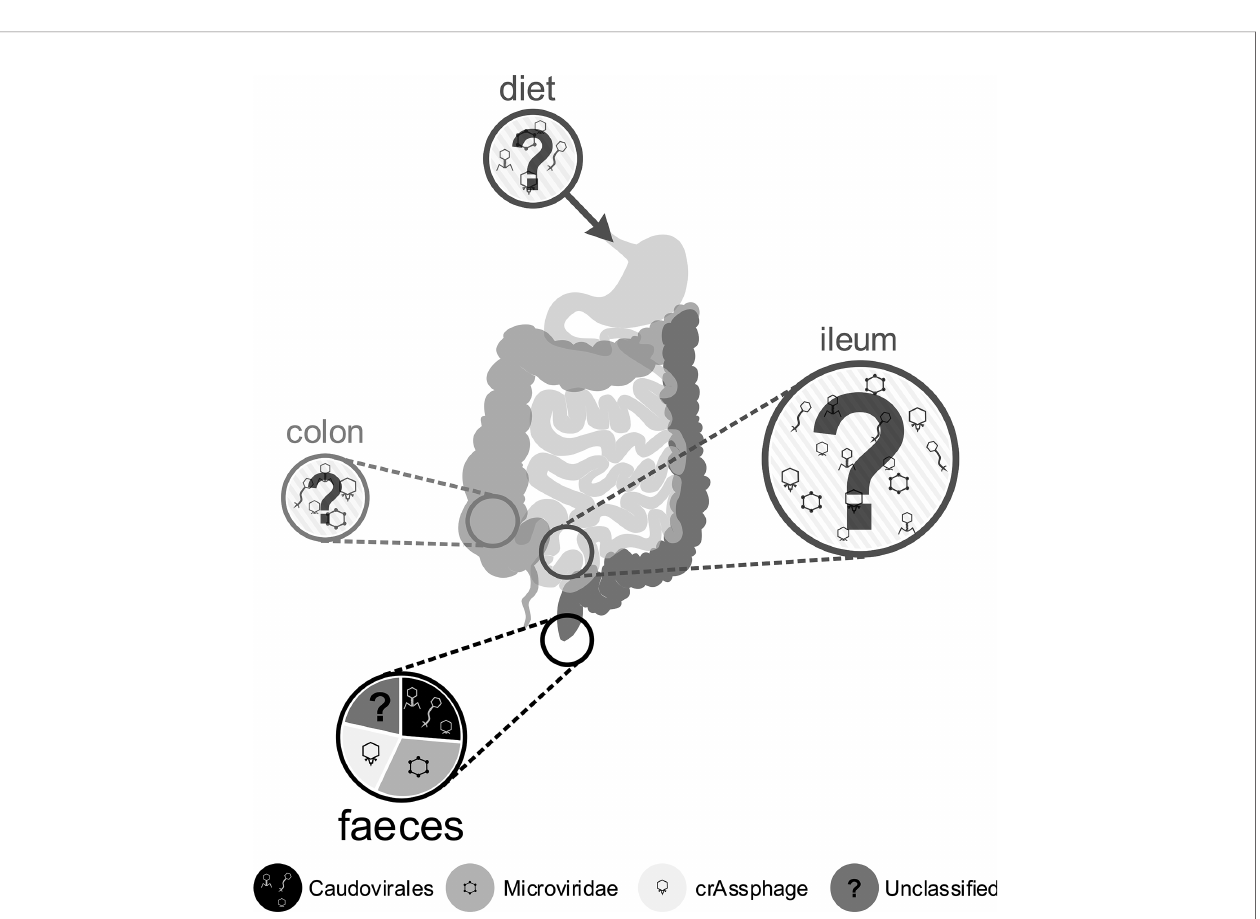
FIGURE 2 | Schematic of the human gut, indicating unknown inputs to the gut phageome from diet and the environment, highlighting the largely unknown phage composition of the ileum and colon and indicating the relative proportions of phages in the best understood samples: faeces. Circle size provides a rough guide to the relative abundance of phage particles observed in different gut compartments (Zoetendal et al., 2012; Hoyles et al., 2014; Shkoporov and Hill, 2019), but current understanding is still lacking. Most research activity has focused on faecal samples, represented in the lowest pie chart, depicting the relative proportions of different phage groups identi fi ed through metagenome analysis, based on Shkoporov and Hill (2019).